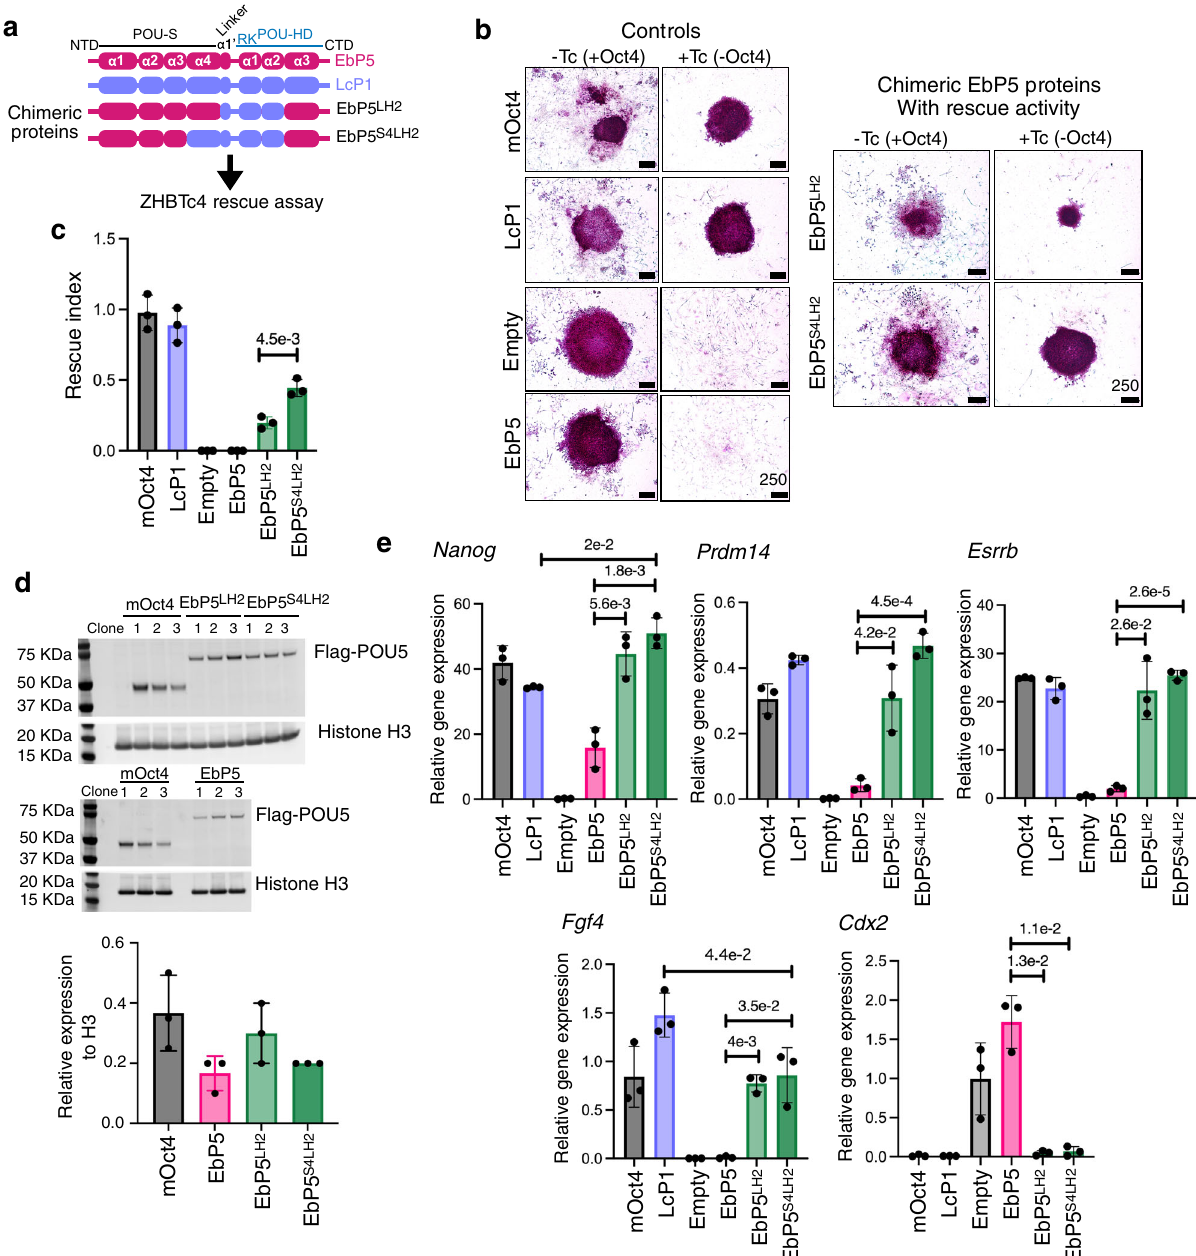
Fig. 8 | Replacing speci fi c regions of hag fi sh POU5 with their coelacanth POU5F1 counterparts is suf fi cient to rescue pluripotency in OCT4-null mouse ESCs. a Design of the hag fi sh-coelacanth (EbP5-LcP1) chimeras used to test rescue capacity in OCT4-null mouse ESCs. b Colony phenotypes of ZHBTc4 cells trans- fected with different chimeric POU5 proteins grown in the presence or absence of mouse Oct4 (±Tc) and stained for alkaline phosphatase (AP) activity (purple). c Rescue index of OCT4-null ESCs rescued by chimeric hag fi sh POU5 proteins. d Western blot showing protein expression of 3x fl ag-tagged chimeric Eb-Lc POU5